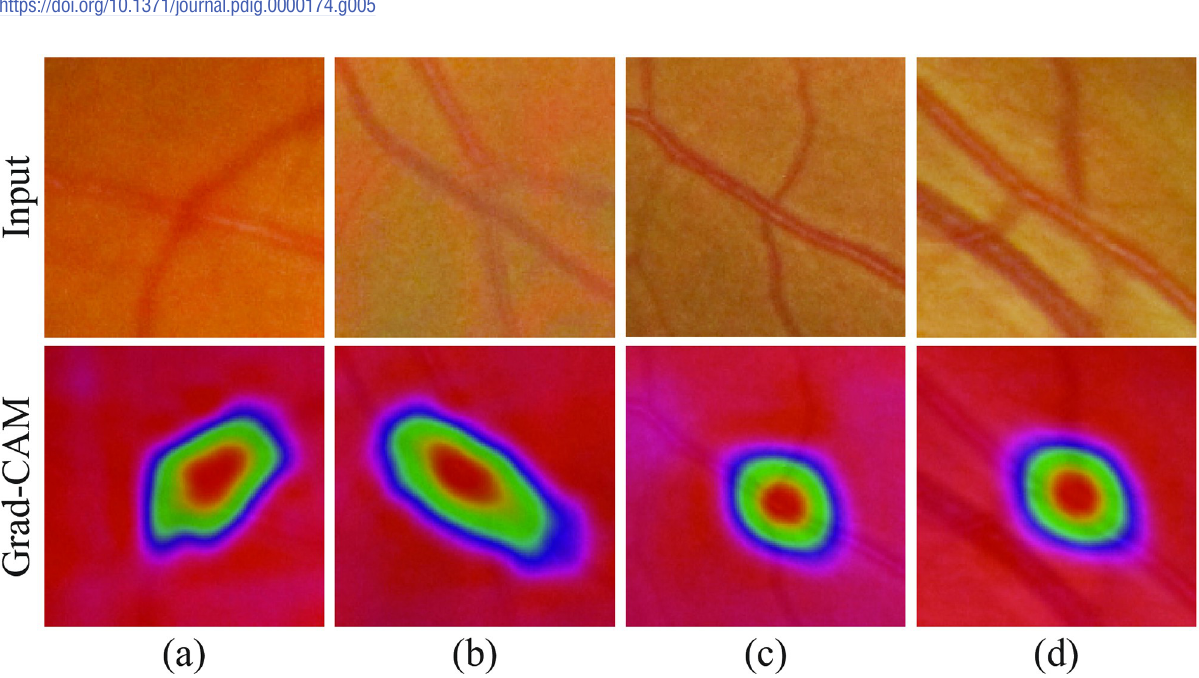
Fig 5. Confusion matrices for three different severity grade prediction models. The recall is shown in the last row and the precision is shown in the last column. (a) MDTNet without the focal module, (b) MDTNet for n = 1, and (c) MDTNet for n = 3.